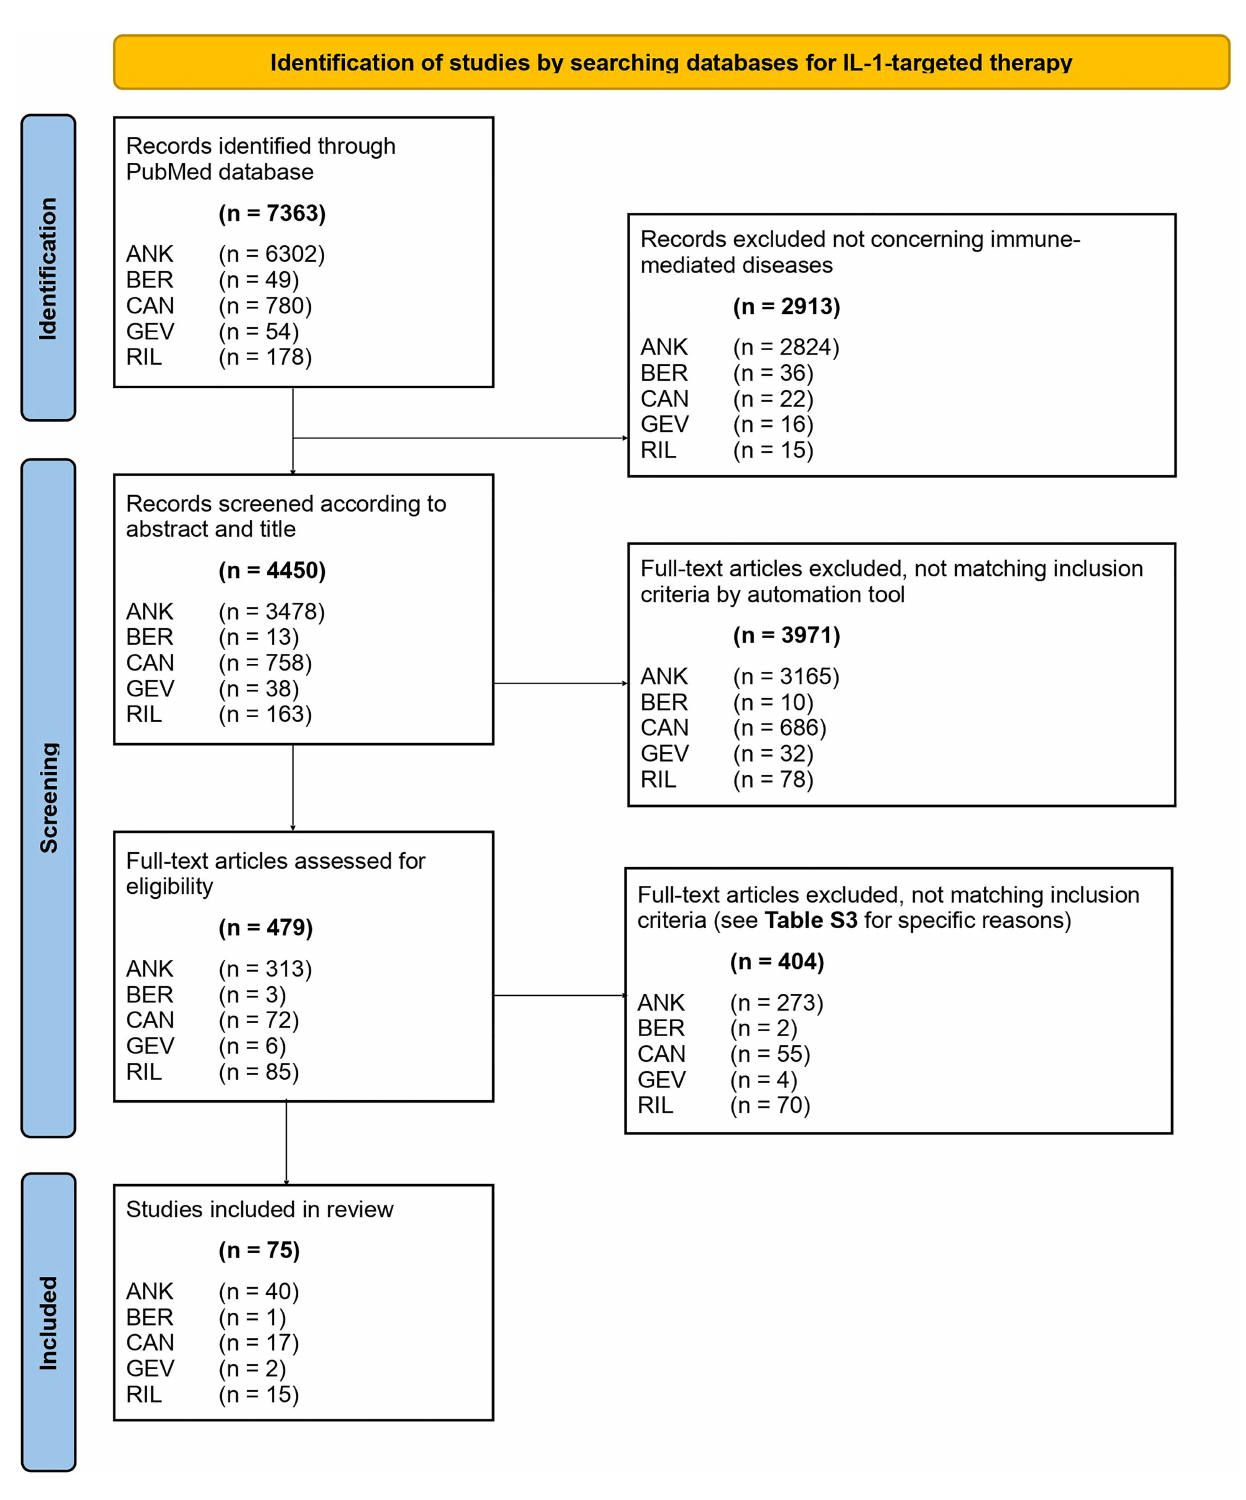
FIGURE 1 | PRISMA 2020 fl ow diagram of literature search. ANK, anakinra; BER, bermekimab; CAN, canakinumab; GEV, gevokizumab; RIL,